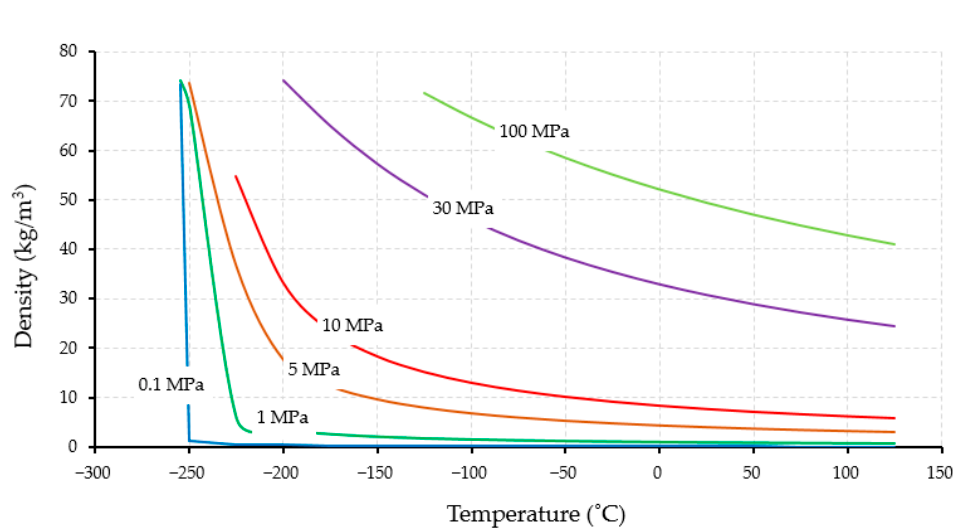
Figure 2. Correlation of hydrogen density and temperature under different pressure [23].